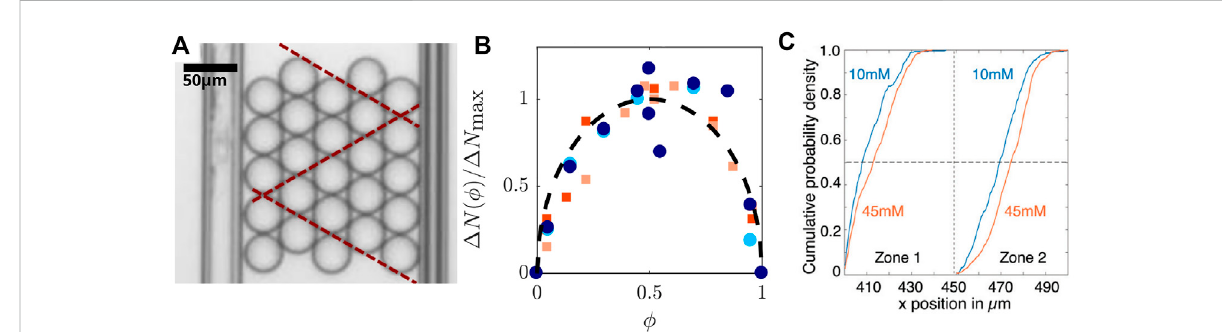
FIGURE 2 Plasticity in attractive emulsions (A) Transmission microscopy image of an oil-in-water emulsion under compression between a force sensor and a pushing plate. Dislocation arrays in the monodisperse emulsions are indicated with the dashed red lines. (B) The forces measured under compression display peaks corresponding to fracture events in monodisperse emulsions or more isolated rearrangements in polydisperse emulsions. The graph in (B) displays the normalized excess number of force peaks during compression with respect to those observed in a monodisperseemulsion,asafunctionofthefractionofdefects Φ introducedthroughbidispersity,foremulsionswith3(squares)or4(circles)rowsin theinitialpacking.Highmonodispersity( Φ =0or1)leadstothesmallestnumberofforcepeakscorrespondingtolargefractureevents.Atthehighest number of defects, the emulsion is disordered, leading to a higher number of peaks of smaller forces. (A,B) were adapted with permission from [38]. (C) Cumulative distributions of theminimum velocitylocationsof droplets fl owed in a2Dconvergent channelwith low (10 mM SDS) or high (45 mM SDS) depletion attraction. The velocity minimum is a reporter for the location of rearrangements, before which the droplets stall. This indicated that the rearrangements are impaired by higher attraction forces and appear further down in the constriction. Adapted with permission from